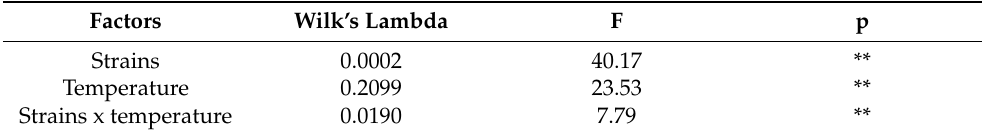
Table 3. Bifactorial MANOVA of the effects of strains and low temperatures and their combined effects on bacterial extracellular enzyme